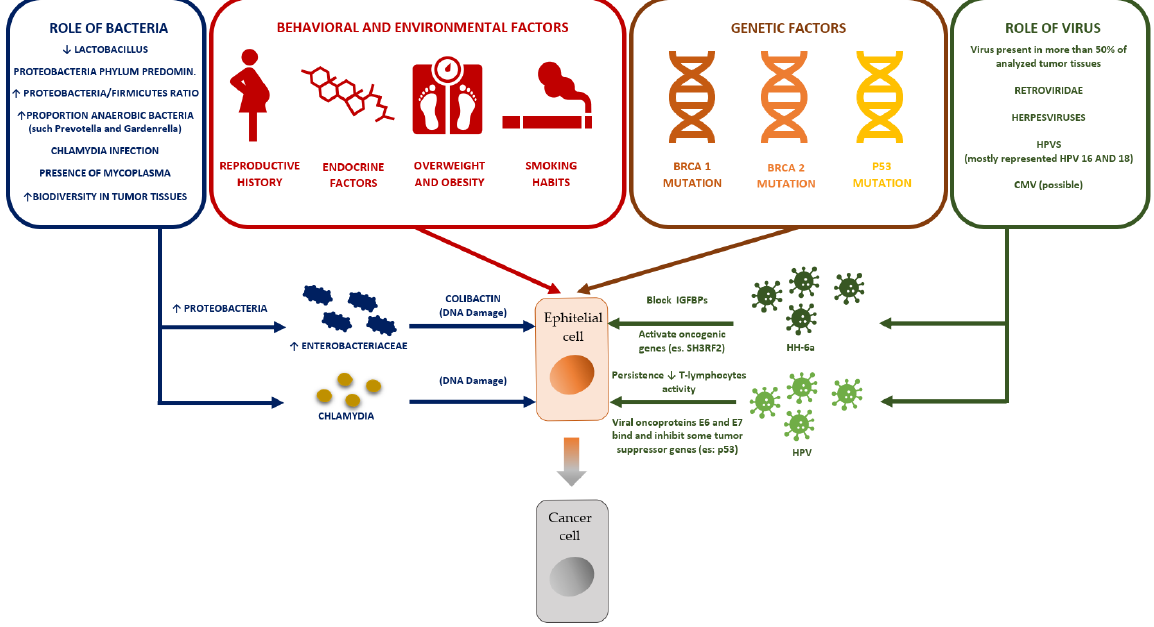
Figure 5. Summary of mechanisms potentially involved in the development of ovarian cancer: environmental and behavioral factors; genetic factors; the role of bacteria; the role of viruses (see text).